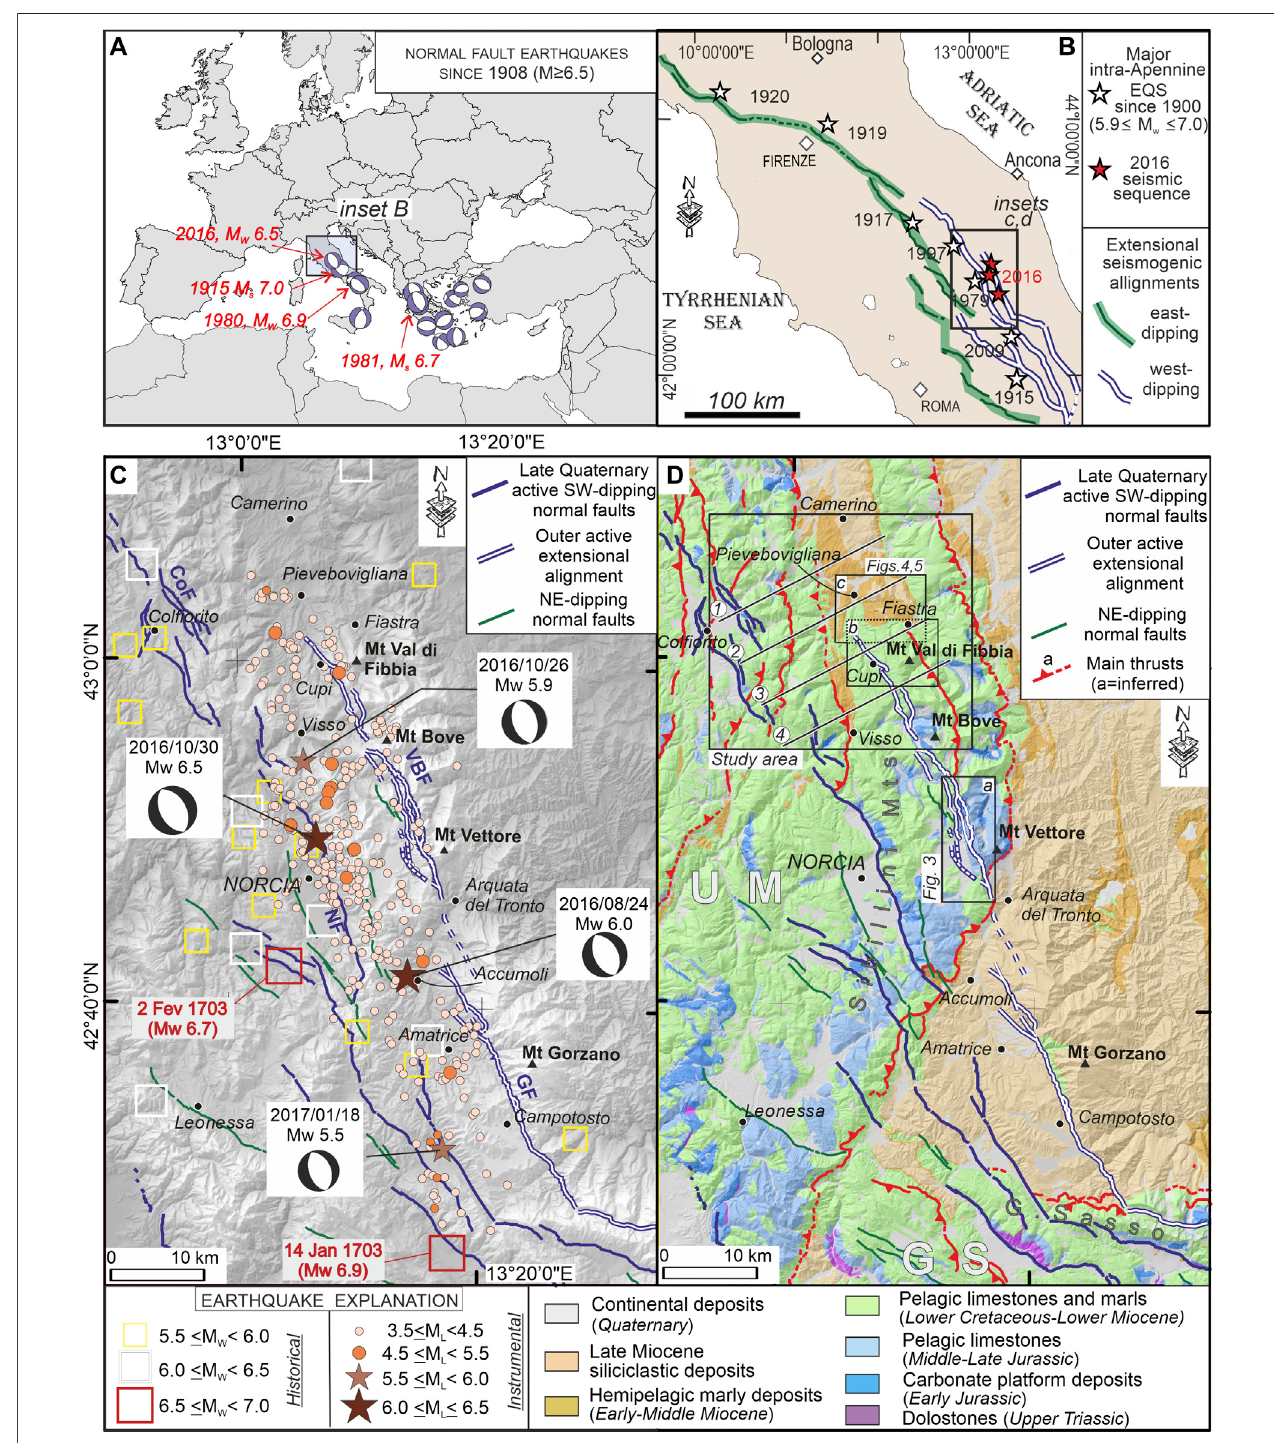
FIGURE 1 | Regional- and seismological background of the 2016 M w 6.5 Norcia earthquake. (A) Map of the most energetic normal fault earthquakes (M ≥ 6.5) occurredintheMediterraneanregionsince1908(focalmechanismsarefromHeidbachetal.,2018). (B) structuralsketchofthemainwest-andeast-dippingextensional alignmentsknownincentralItaly(fromLavecchiaetal.,2017)withtheoccurrence,startingfrom1900,ofthemostenergetic(M ≥ 5.9)historicalearthquakes(fromRovida etal.,2021). (C) epicentraldistributionofthehistorical-andinstrumentaleventsoccurredintheNorcia2016seismicsequenceepicentralarea.Historicalseismicity is from Rovida et al., 2021 (M w ≥ 5.0 – from 1005 AD to 2016/08/23) while instrumental seismicity is from Chiaraluce et al., 2017 (M L ≥ 3.5 – from 2016/08/24 to 2018/12/ 31). Focalmechanisms ofthefour major events arealso reported. Themain tectonic lineaments belonging totheSW- and NE-dipping normal fault systems arefrom the